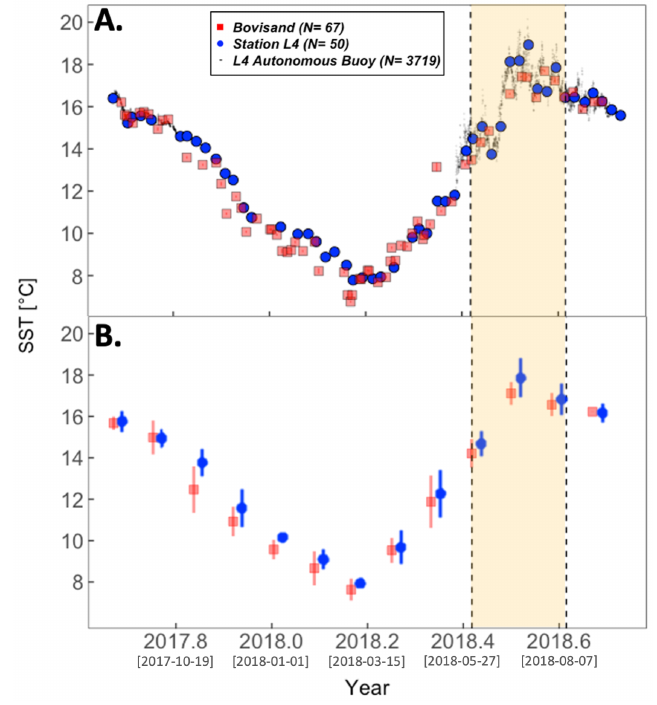
Figure 5. ( A ) Time series of SST from Bovisand in-situ data (red squares) and Station L4 data (blue circles). SST data from the L4 autonomous buoy are underlain in ( A ) (black dots) as a way of verifying the trends seen in the in-situ Bovisand and Station L4 data. ( B ) is the monthly binned averages of the Bovisand and Station L4 in-situ SST data in ( A ). Vertical bars in ( A ) represent the measurement uncertainty and in ( B ), represent the standard deviation of the bins. The yellow shaded area represents the summer period June to August. Data for Station L4 were available from the WCO data repository [84]. Square bracketed dates on the x-axis ticks represent